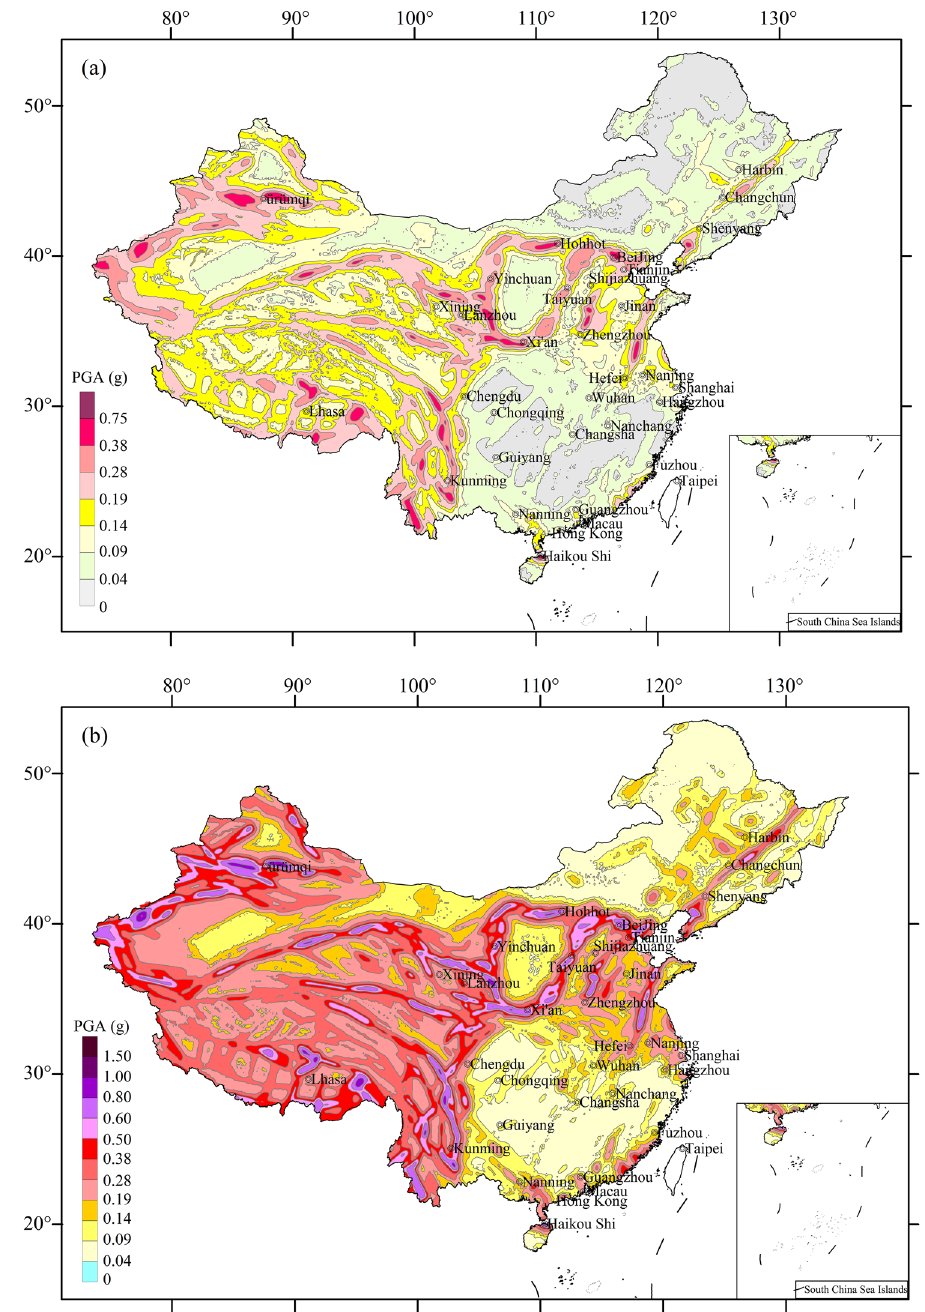
Fig. 8 Peak ground acceleration (PGA) values amplified by site conditions at 10% ( a ) and 2% ( b ) probability of exceedance in 50